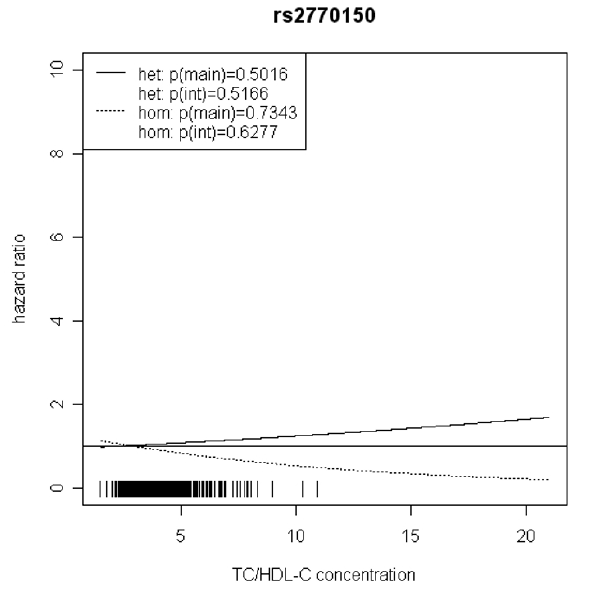
Figure 9 Hazard ratios of incident type 2 diabetes related to the respective TC/HDL-C concentration in women for rs2770150 . Dashed lines represent subjects who are homozygote for the minor allele, while continuous lines show heterozygotes. Small bars at the x-axis indicate TC/ HDL-C concentrations of patients with at least one copy of the minor allele.